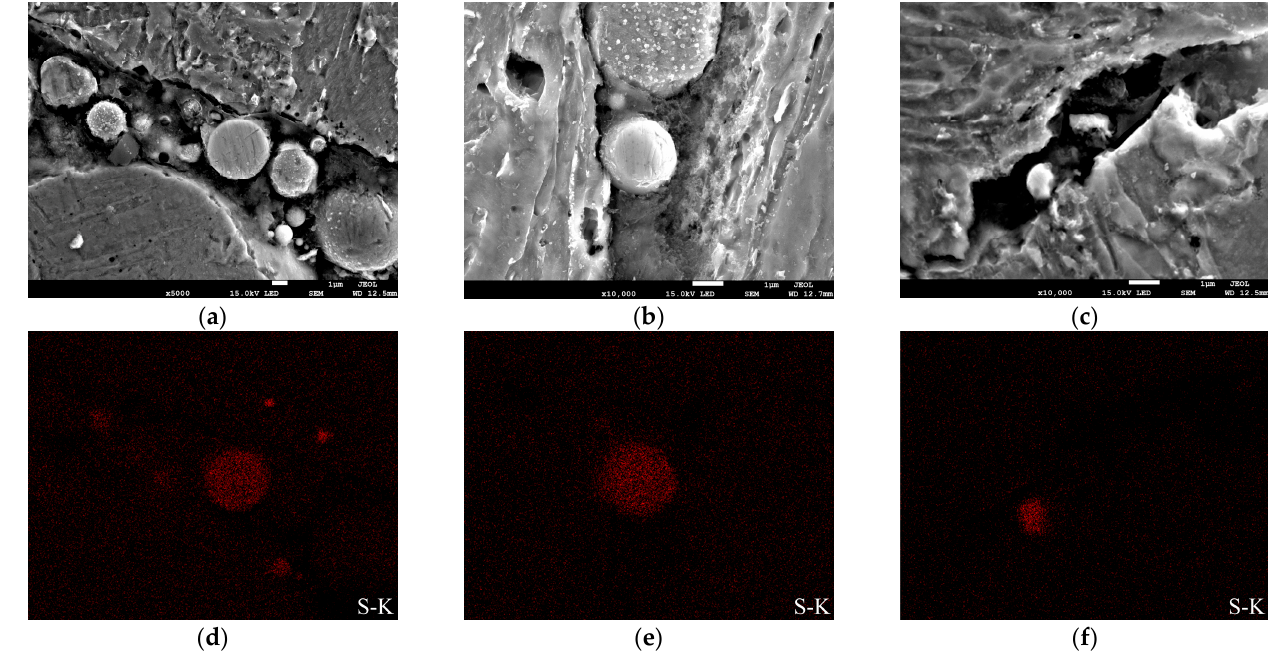
Figure 11. SEM morphology near cracks in the H 2 S ‐ containing environment: ( a ) WM, ( b ) CGHAZ, ( c ) SCHAZ; S distributions analyzed via EDS mapping near cracks in the H 2 S ‐ containing environment: ( d ) WM, ( e ) CGHAZ, ( f ) SCHAZ.